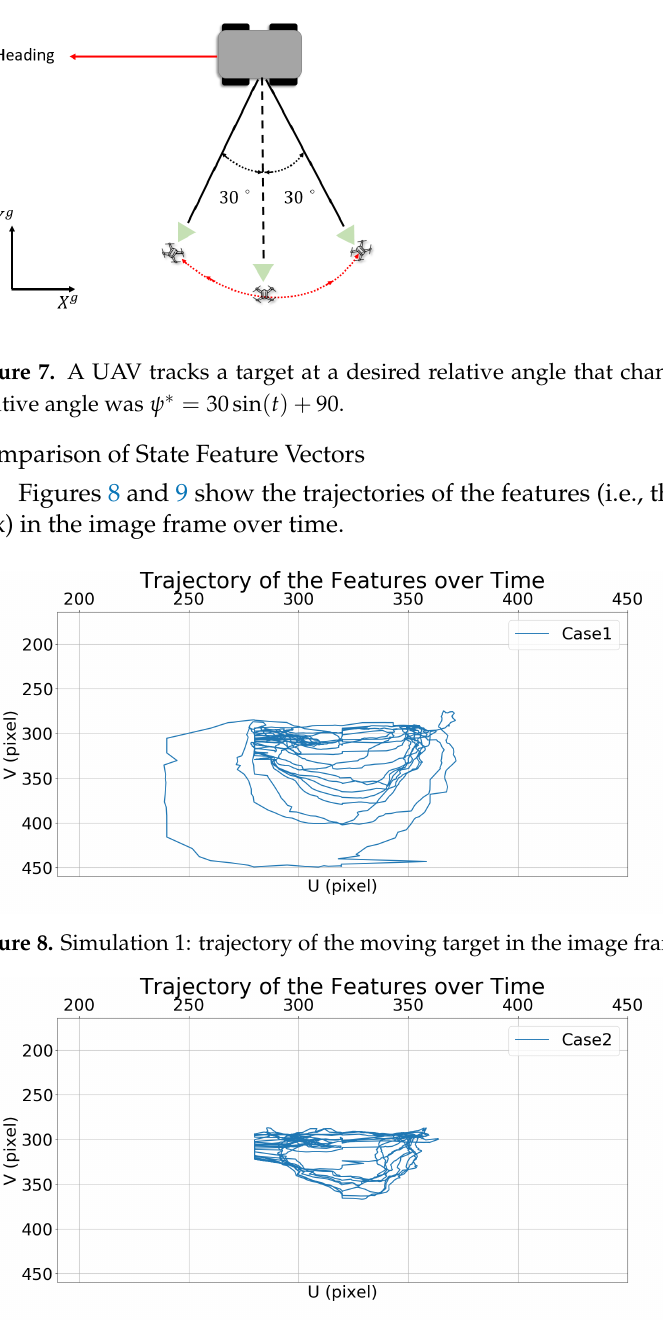
Figure 9. Simulation 1: trajectory of the moving target in the image frame for Case 2. The performances are quantified as the root mean square (RMS) tracking errors defined in Table 4. Table 4. Simulation 1: RMS